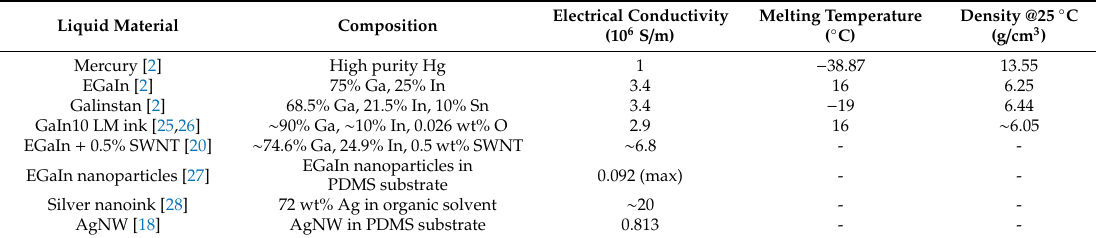
Table 1. Properties of popular conductive fluids used in antenna design. Additional LM material properties are available in [7,19,24]. (Silver nanoink and AgNW added for comparison only). Abbreviation: SWNT, single-walled carbon nanotube; AgNW, silver